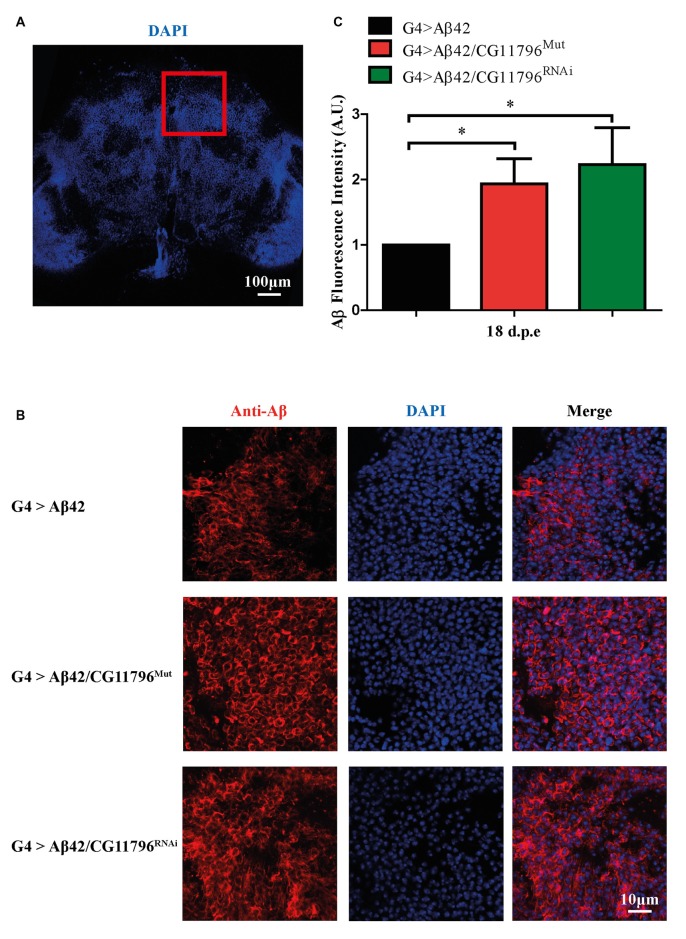
Immunofluorescence of Aβ deposits in the brains of transgenic lines. (A) Representative image of a brain section at low magnification stained with DAPI. The red square depicts the region used for quantification in each genotype. Scale bar = 100 μm. (B) Representative images of the selected region as in panel (A) showing from left to right: anti-Aβ, DAPI nuclear staining and the merge of both signals. Scale bar = 10 μm. Genotypes G4 > Aβ42, G4 > Aβ42/CG11796Mut and G4 > Aβ42/CG11796 RNAi are shown. (C) Quantification of Aβ fluorescence intensity normalized to G4 > Aβ42 in A.U. showing the increment induced by CG11796 mRNA reduction. Bars represent the mean-ratio ± SEM of three independent experiments; *p < 0.05 (Wilcoxon test).